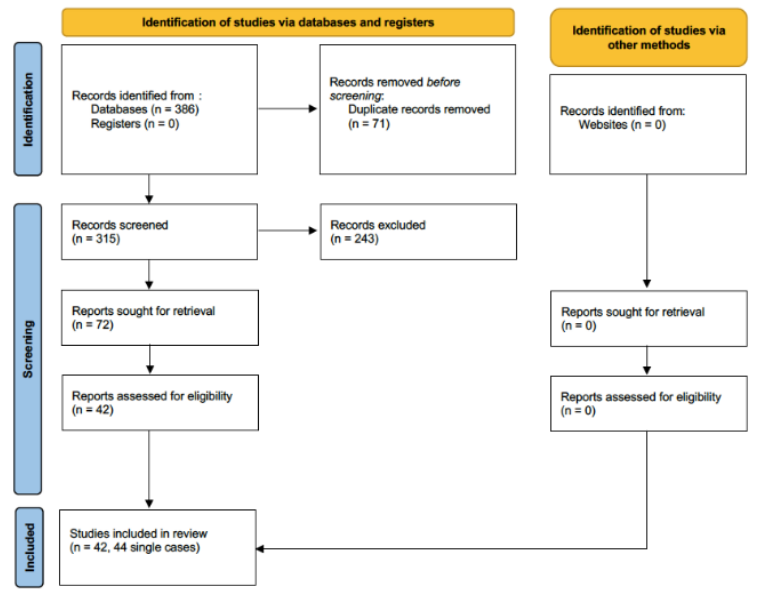
Figure 1. PRISMA flow diagram. Table 1. Summary of findings.